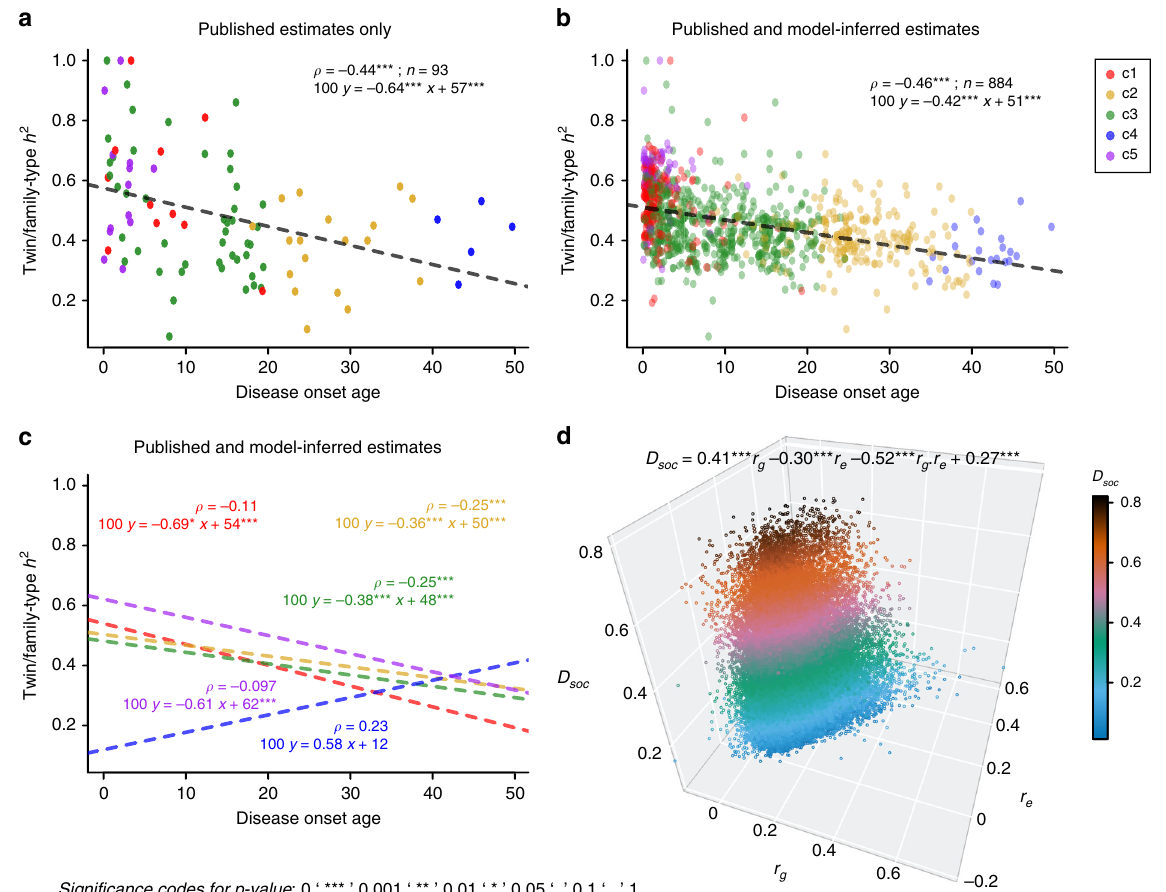
Fig. 4 Analyses empowered by our estimates of heritability ( h 2 ), and genetic and environmental correlations ( r g and r e ). Plate a includes analyses solely based on the previously published estimates of twin/family-type h 2 , suggesting a signi fi cantly negative correlation between disease onset age and heritability. b Our estimator substantially enriched the collection of twin/family-type h 2 estimates, fi lling in numerous missing estimates for under-studied diseases. When we analyzed disease prevalence curves jointly, we found a signi fi cantly negative correlation between disease onset age and h 2 , which also holds for h 2 estimates based on other data types, such as SNP/PRS-type (Supplementary Fig. 4b). c We performed the same analysis for diseases within each of the fi ve curve shape clusters, also con fi rming the signi fi cantly negative correlations for shape Clusters 1 – 3. In the smaller Clusters 4 and 5, the correlations were not signi fi cant (Methods part 5). d To understand the relationship between a disease pair ’ s dissimilarity of disease prevalence curves ( D soc ), and the r g and r e for the same disease pair, we performed a regression analysis, expressing D soc as a function of r g , r e , and an interaction term r g · r e ( p values were computed using Student ’ s t test, see Methods part 6). The corresponding regression coef fi cients turned out to be 0.41, − 0.30, and − 0.52, respectively. This regression analysis suggests the following: When two diseases have only high genetic correlation, their prevalence curves are likely to be very different; if only environmental correlation is high, the prevalence curves tend to be much more similar. However, disease prevalence curves are most similar when both environmental and genetic correlations between the two diseases are high. The included disease pairs across all categories are represented as hundreds of thousands of data points in the plot and they are colored according to the D soc values. We also repeated the same D soc regression analysis with all disease pairs from distinct disease categories (see Supplementary Data 6 and Supplementary Fig.